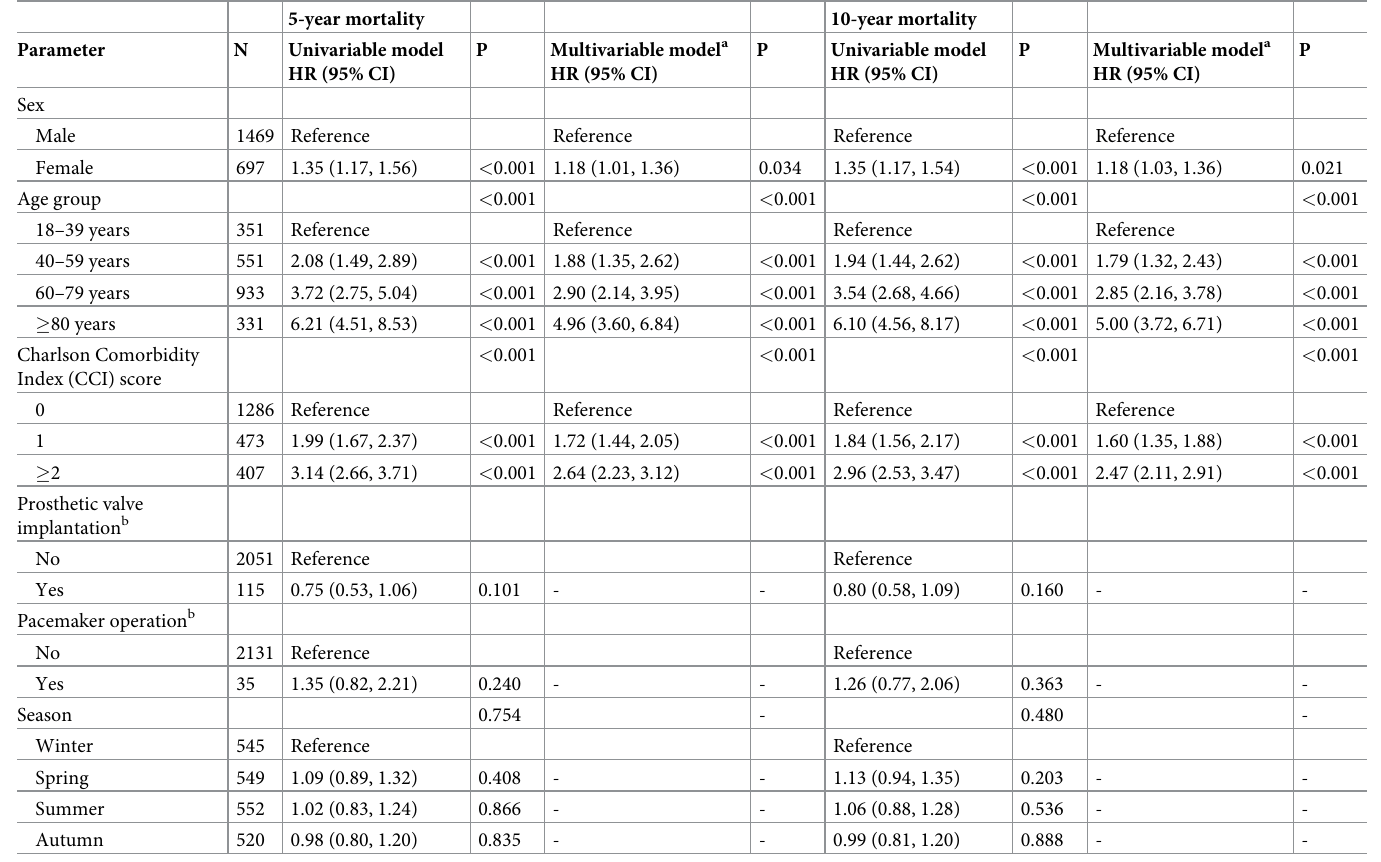
Table 3. Predictors of 5-year and 10-year mortality after infective endocarditis admission during 2005–2014 in Finland (n =